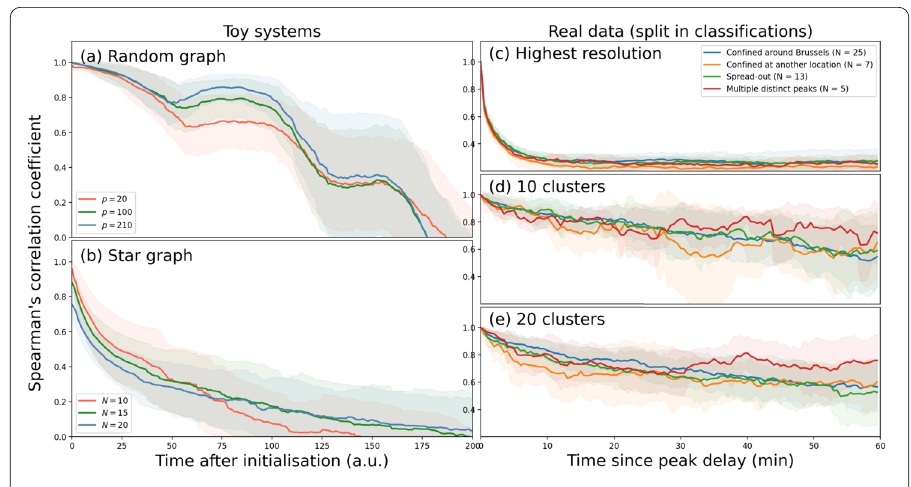
Figure 5 Model performance in toy systems and across classifications of disrupted days. Panel ( a ): Model performance of the random toy system for three different values of the amount of lines p (see Additional file 1, Appendix D for details). Panel ( b ): Model performance of the star graph toy system for different values of the amount of nodes N (keeping p fixed, see Additional file 1, Appendix D for more details). Panel ( c )–( e ): Model performance along time since peak delay of the disrupted days, averaged within each classification (see Additional file 1, Appendix B for details), for the model at ( a ) highest resolution, ( b ) using K = 10 and ( c ) using K = 20 clusters. Averages are shown in lines, shaded areas indicate the range of one standard deviation from the average